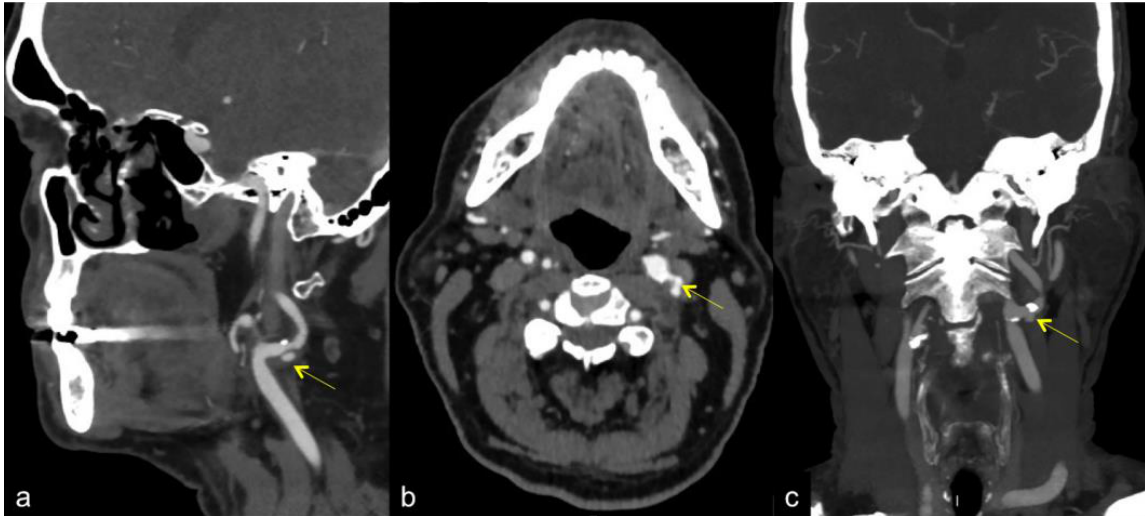
Figure 1. CTA arterial phase sagittal ( a ), axial ( b ), and coronal ( c ) multiplanar reconstructions show an ulcerative left carotid internal artery plaque (arrow; a – c ).